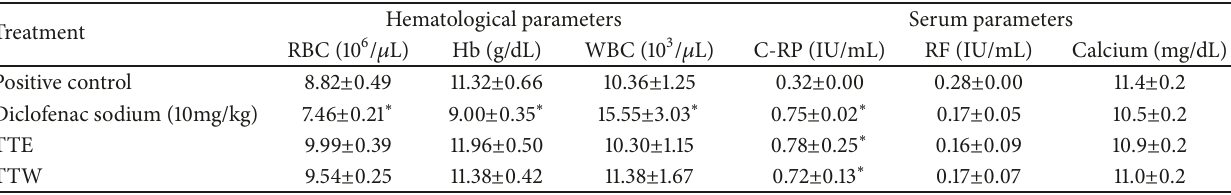
Table 1: Alterations in hematological, serum parameters in CFA induced arthritis in Wistar rats. Results expressed as mean ± SEM (n = 6) analyzed by one-way ANOVA followed by Dunnett's post hoc test, ∗ p < 0.05 as compared with positive control [RBC: red blood cell; Hb: hemoglobin; WBC: white blood cell; CRP: C-reactive protein; RF: rheumatoid factor].